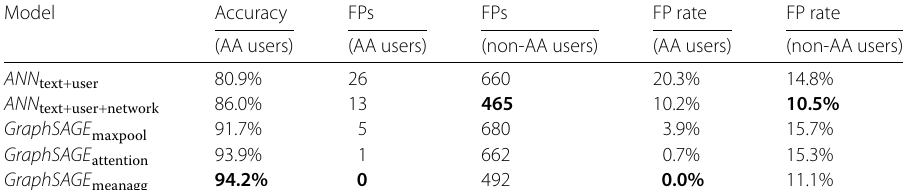
Table 3 Fairness Evaluation Metrics (African–American denoted as AA, False positive denoted as FP) Model